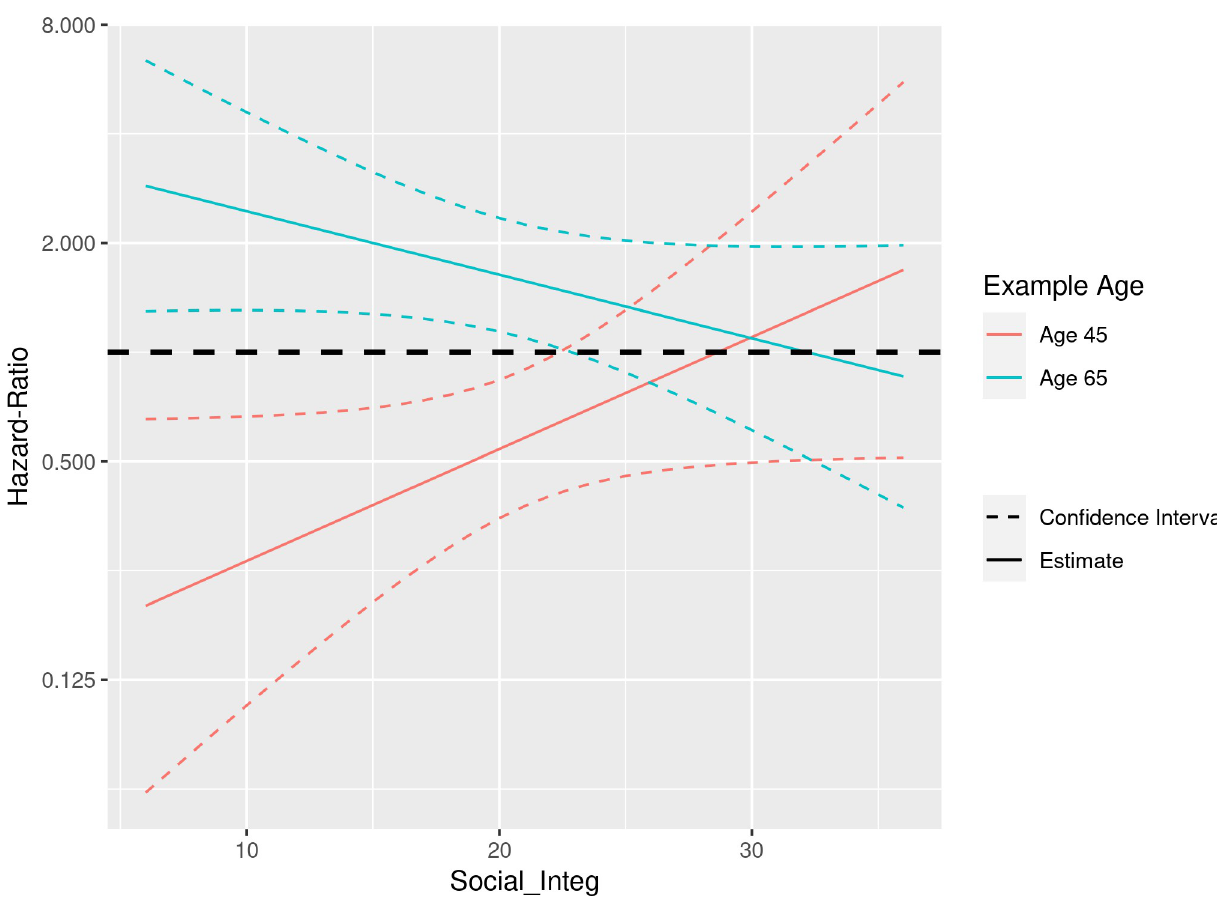
Fig 2. Age and lack of social integration among older women with CAD. There is an interaction between social integration and age. The predicted risk ratio for mortality increases with the degree of social isolation in older women (65 years) and decreases in younger women (45 years). This result could be plausible, as a lack of social integration could be an additional strain for older